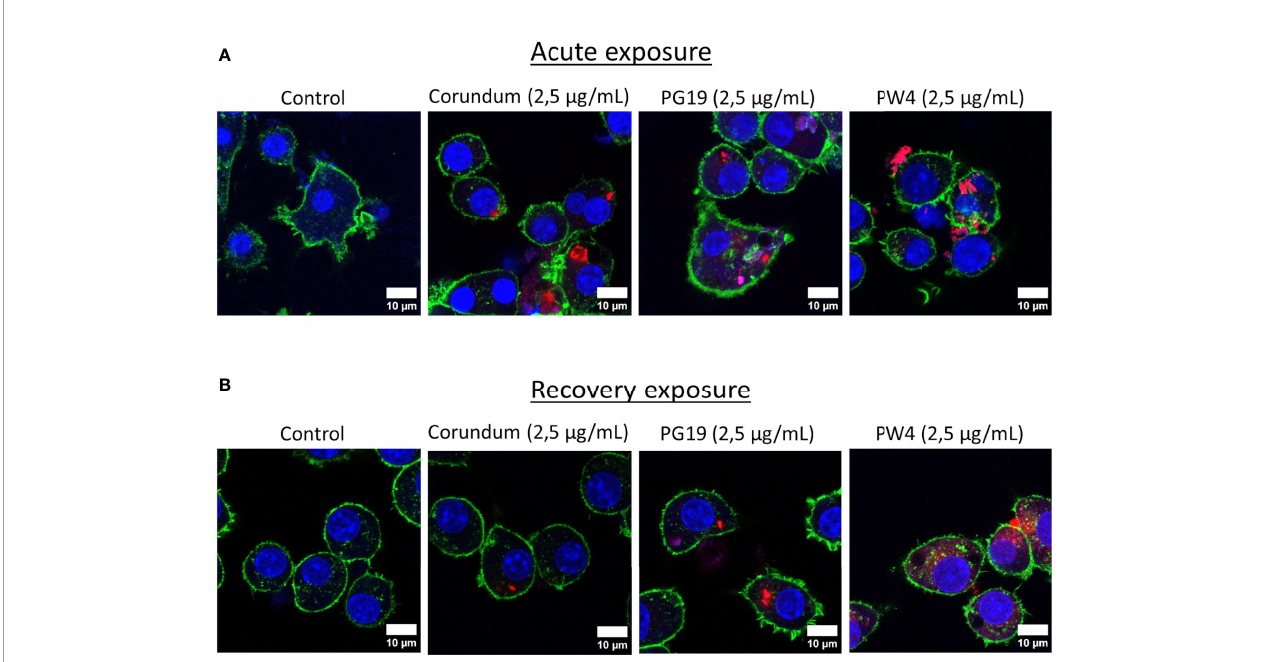
FIGURE 4 | Visualization of pigment uptake with Rhodamine isothiocyanate (RITC)-coupled pigments. Panel (A) confocal microscopy visualisation of macrophages after acute exposure with pigments. Panel (B) confocal microscopy visualisation of macrophages after recovery exposure with pigments. Cells were exposed to 2.5 µg/mL of fl uorescent corundum or pigments (PG19 and PW4) for 24h. Green = actin dyed with Phalloidin-Atto 390; blue = nucleus dyed with Sytox ™ Red Dead Cell Stain; red = RITC-pigment. Scale bare = 10